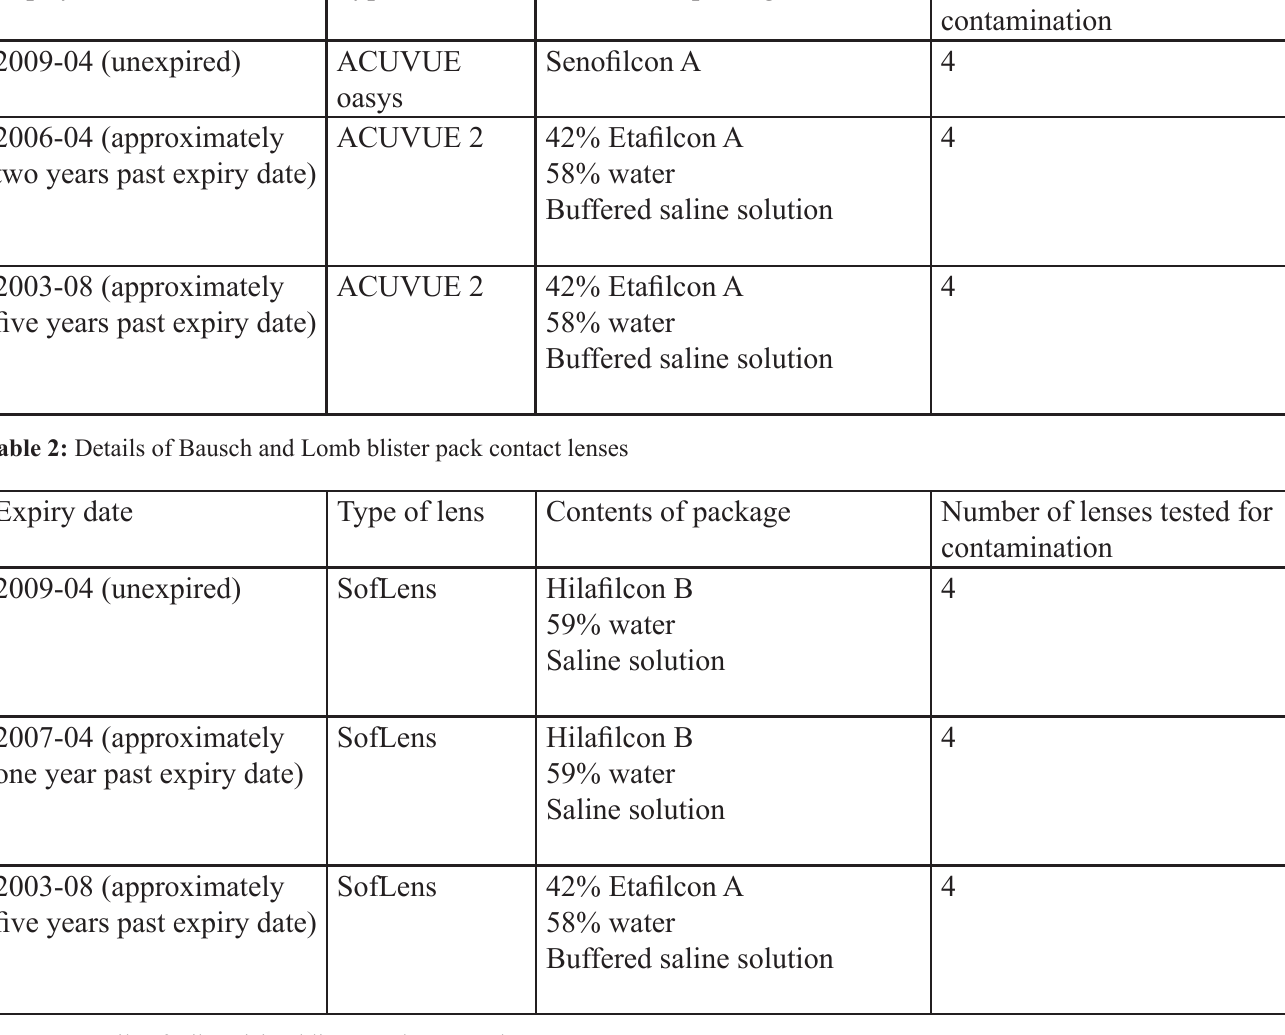
Table 3: Details of Ciba Vision blister pack contact